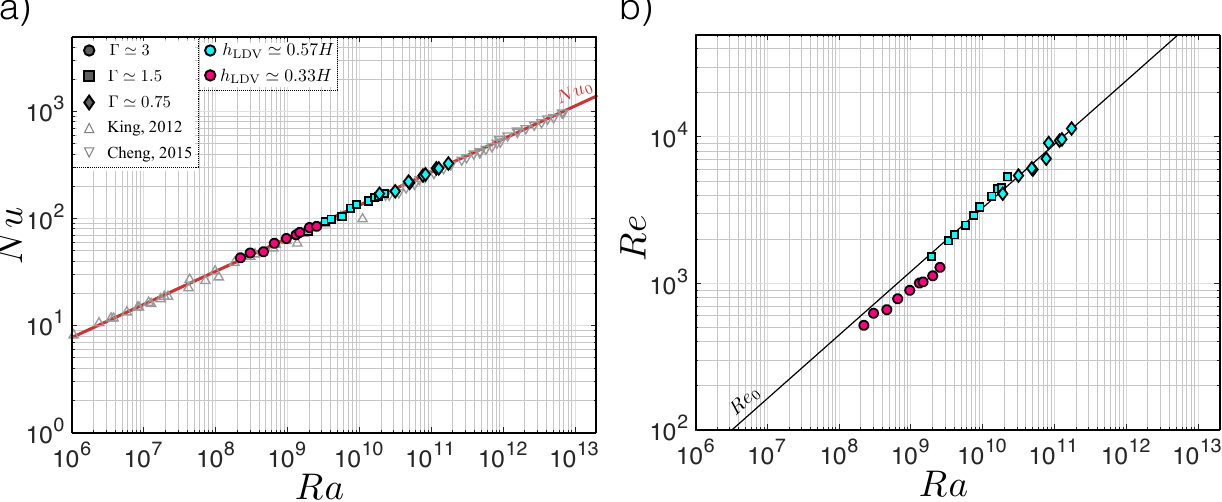
Figure 4. ( a ) Nu vs. Ra RBC results, where pink circles denote data with Γ denote data with Γ 1.5, and cyan diamonds denote data with Γ (cid:39) experimental data from [64], whereas upside-down gray triangles are the experimental data from [65]. The fuchsia line is the best fit to our data, Nu 0 = 0.108 Ra 0.309 , and is in good agreement with the empirical fit to the data from [45]. ( b ) Re vs. Ra RBC results, where the symbol shapes and colors are consistent with those in ( a ). The Γ 3 data are collected at a location of h LDV (cid:39) while the Γ 1.5 and Γ 0.75 data are collected at a location of h LDV (cid:39) (cid:39) solid black line, Re 0 = 0.151 Ra 0.434 , is the best fit to the data at the height of h good agreement with the best fit to the water data in